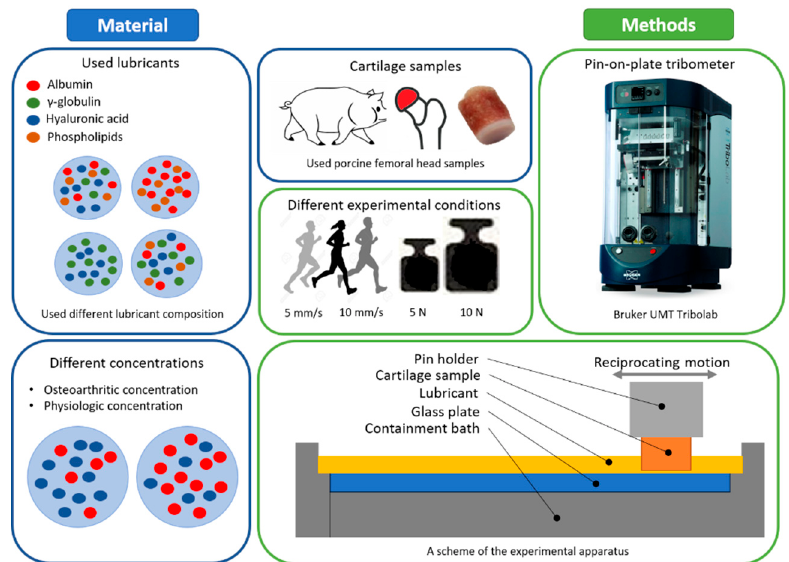
Figure 1. A research plan of the study.